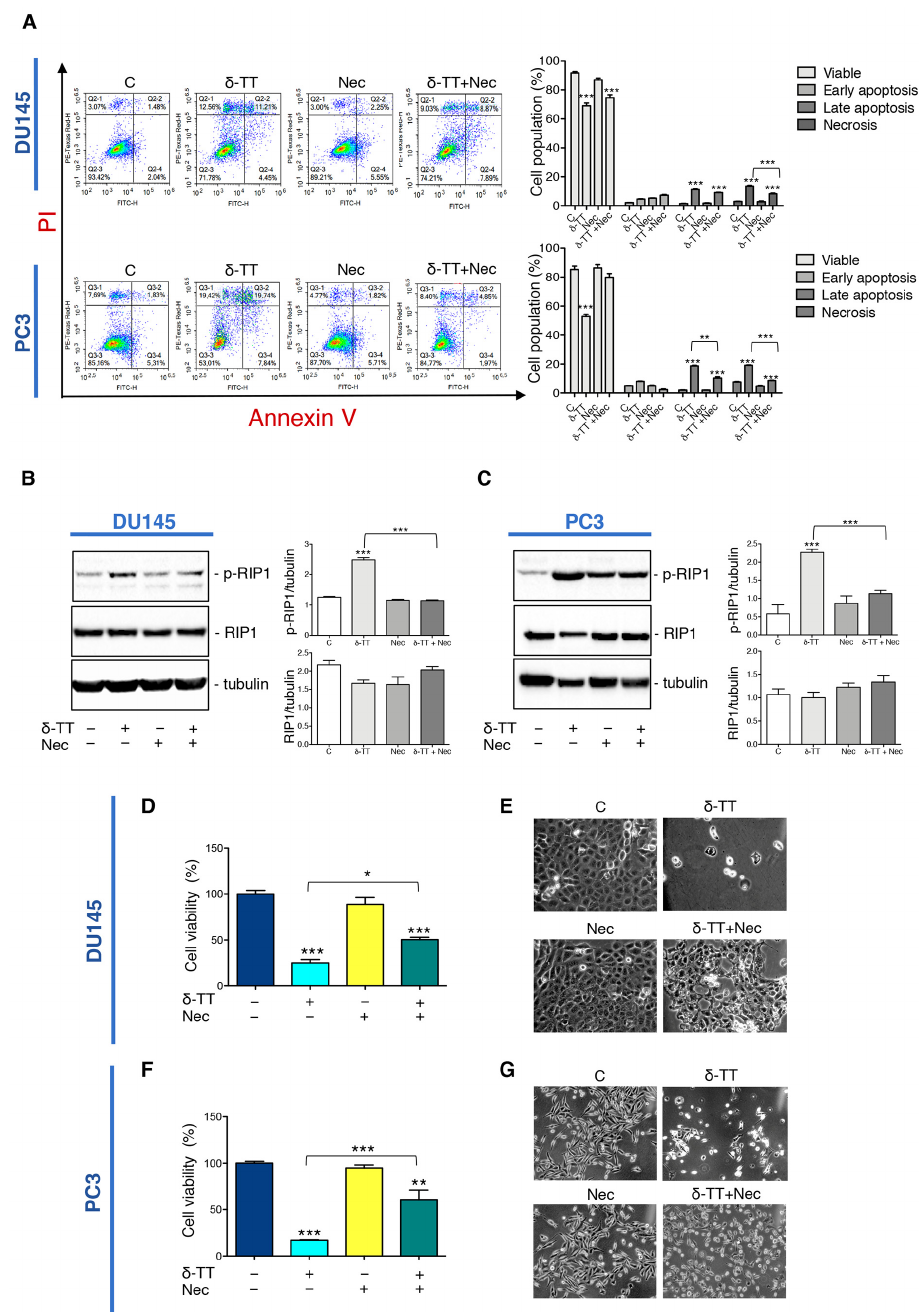
Figure 3. Inhibition of necroptosis prevents δ -TT prostate cancer cell death. ( A ) Flow cytometric analysis by Annexin-FITC/PI double staining was performed after δ -TT treatment (20 μ g/mL, 48 h) in combination with necrostatin-1 (Nec) (50 μ M) in both DU145 and PC3 cells. Three independent biological samples for each condition were analyzed ( n = 3); bar graph represents the mean ± SD. Statistical analysis was performed using one-way ANOVA followed by Bonferroni post-hoc test (** p < 0.01; *** p < 0.001). ( B ) The effect of δ -TT (20 μ g/mL, 24 h) in the presence of Nec (50 μ M) was evaluated on p-RIP1 and RIP1 expression in DU145 cells. Tubulin was used as loading control. Three independent experiments for each condition were analyzed; bar graph represents the mean optical density± SD. Statistical analysis was performed using one-way ANOVA followed by Bonferroni post-hoc test (*** p < 0.001). ( C ) Effect of treatment with δ -TT (20 μ g/mL, 24 h) in presence of Nec (50 μ M) on RIP1 and p-RIP1 expression in PC3 cells. Tubulin was used as loading control. Three